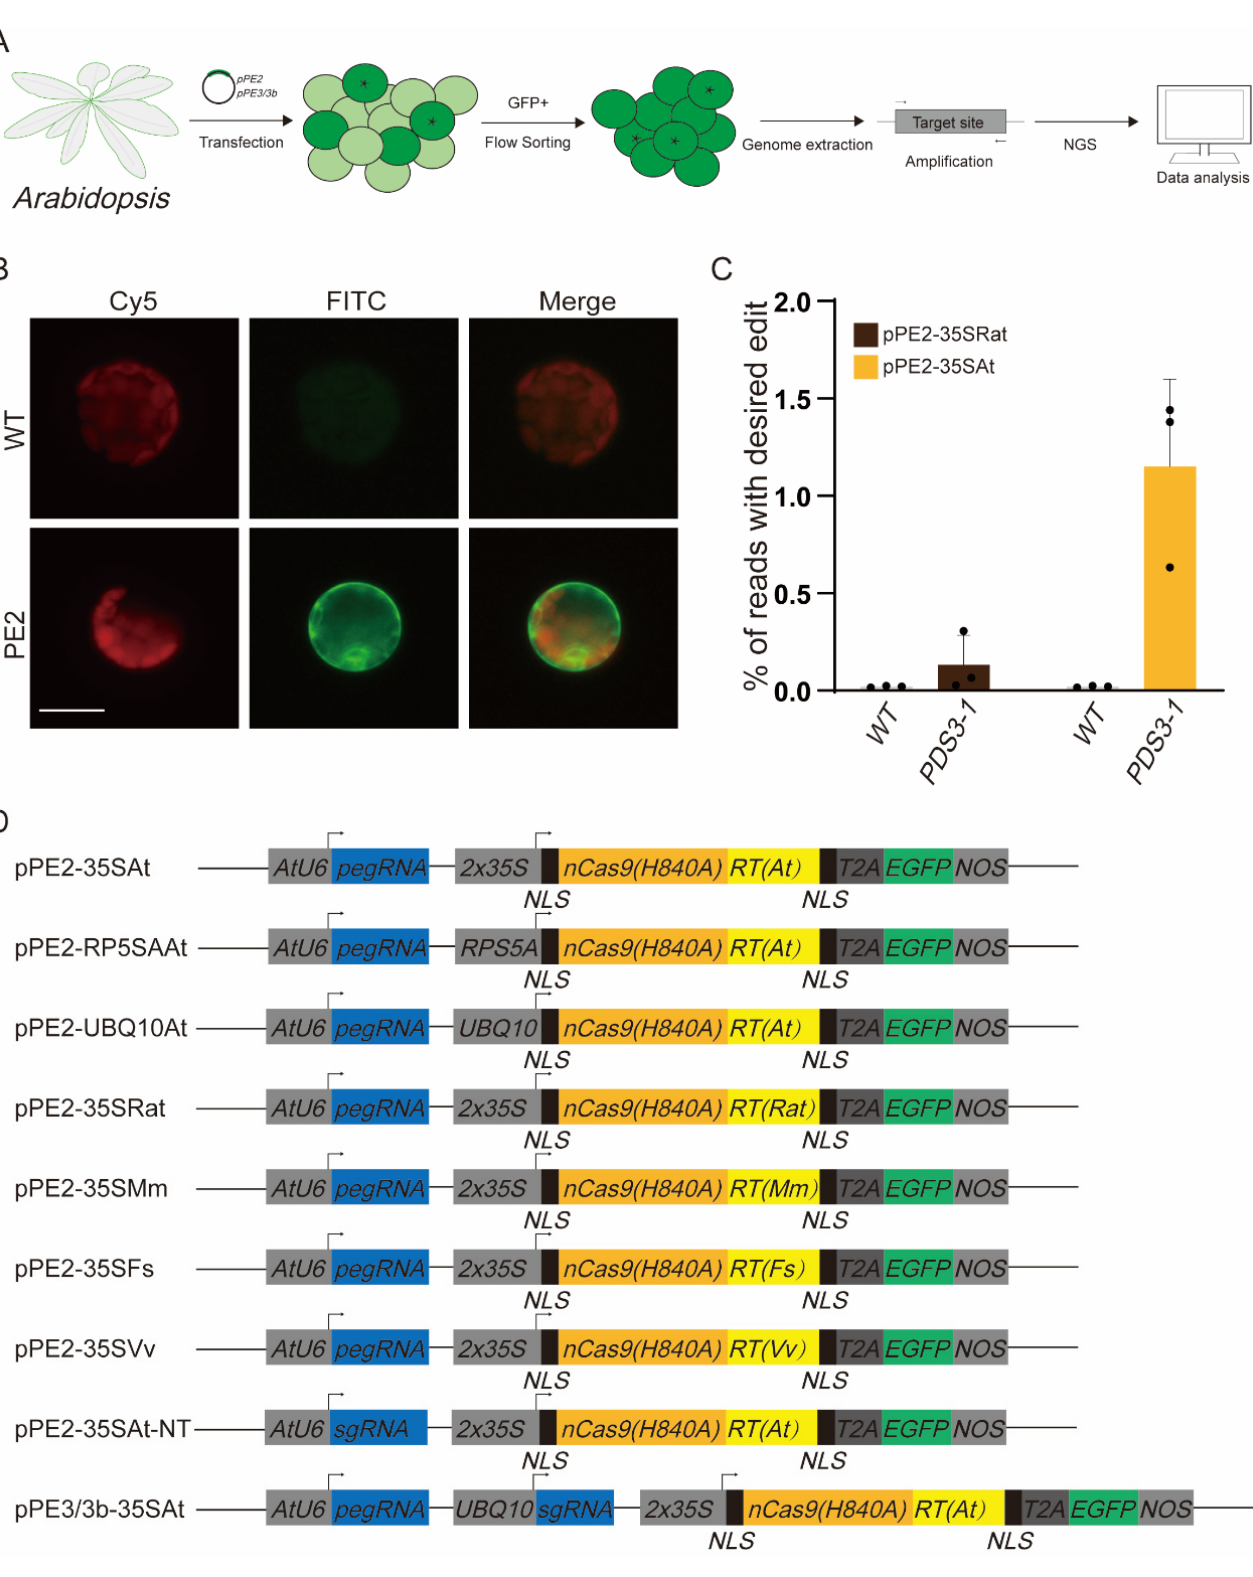
Figure 3. Prime editing in Arabidopsis cells. ( A ) The Arabidopsis cells were transfected with the PE system. The positively transfected cells were selected via flow cytometry. This was followed by genome extraction, amplification of target sequence, NGS, and data analysis. ( B ) Fluorescence of GFP+ protoplasts. Red signal in Cy5 channel indicates autofluorescence from chloroplast, green signal indicates GFP protein overexpressed in the cytoplasm from plasmids. Untreated protoplast served